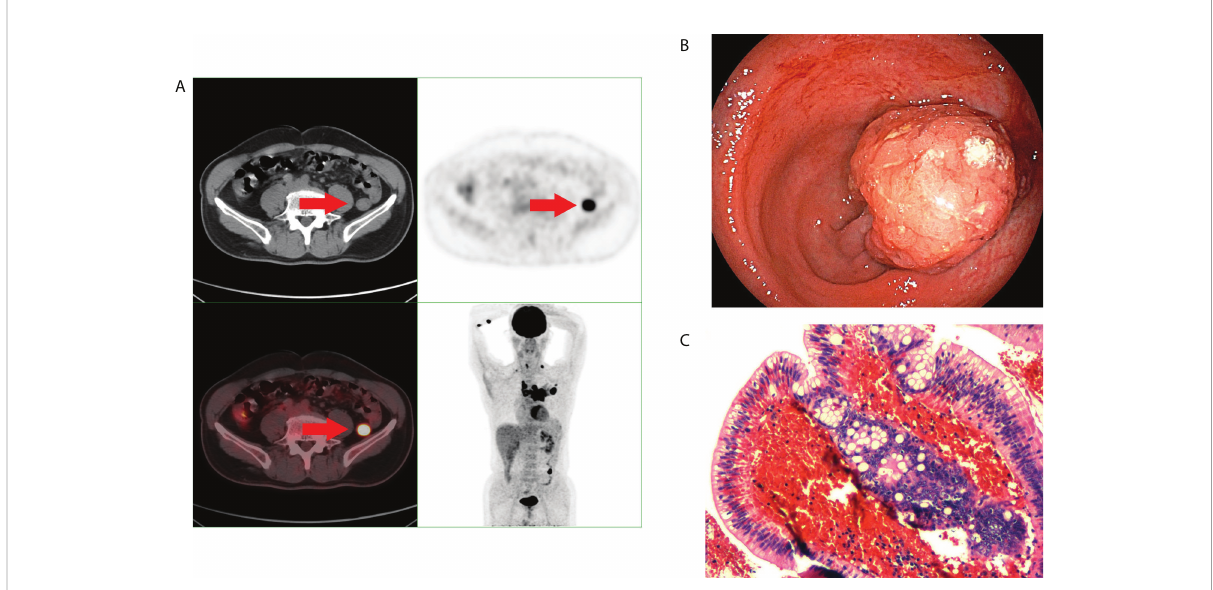
FIGURE 3 A middle-aged man underwent 18F-FDG PET/CT for left pulmonary nodules. Incidental focal uptake of 18F-FDG was found in the rectum. The patient underwent colonoscopy and pathology examination. (A) Abnormal uptake of 18F-FDG PET/CT in the rectum. (B) shows a colonoscopic pedicled polyp with a diameter of approximately 2.0 cm. (C) shows the pathological type of villous tubular